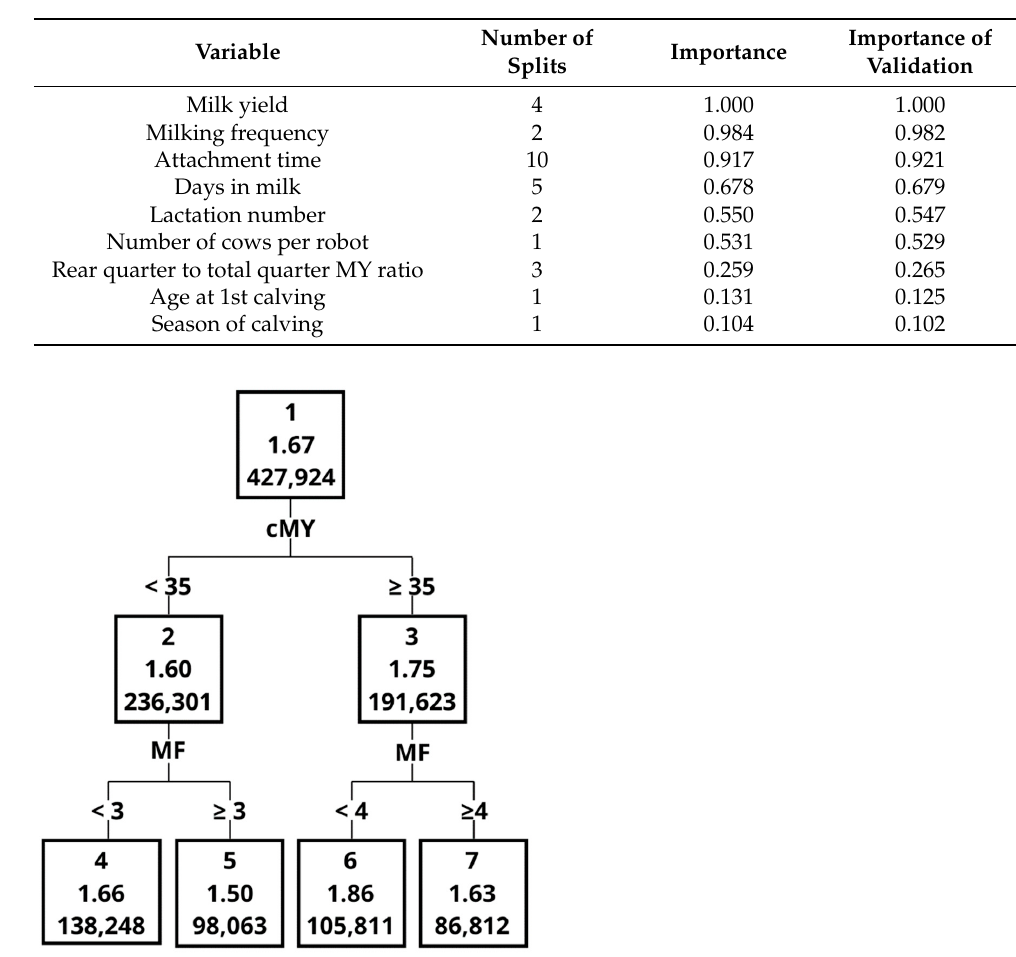
Table 5. Number of division rules and importance of tested variables in tree creation based on Importance measure.